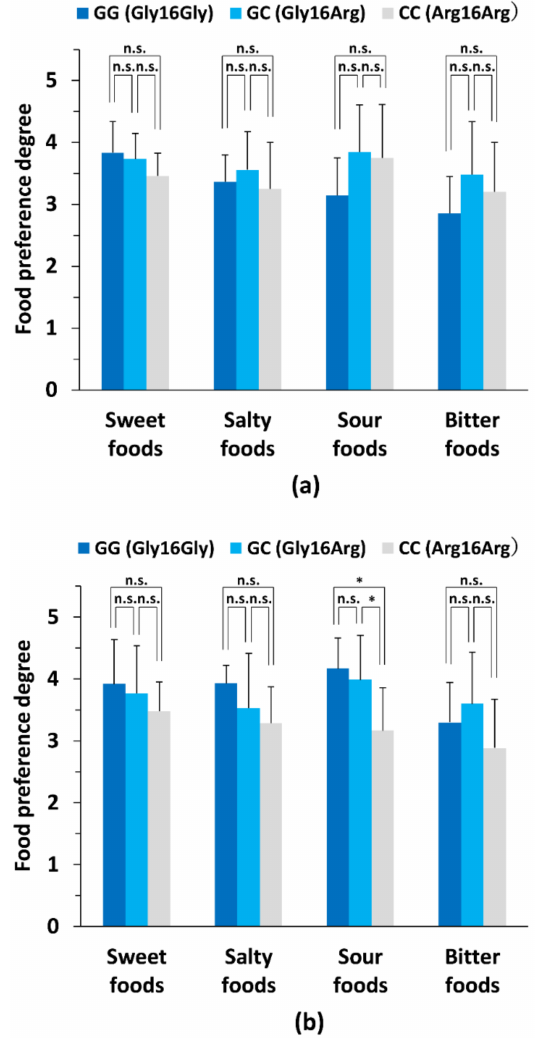
Figure 2. Comparison of primary taste preference degrees between genotype subgroups in male and female subjects. In the self-reporting questionnaire, to determine preferences for primary tastes, subjects rated their degree of taste preferences for a variety of tastants including salty, sour, sweet, and bitter on a scale of 1–5 as presented in Tables 4 and 5 as follows: scale 5, like very much; scale 4, like moderately; scale 3, neither like nor dislike; scale 2, dislike moderately; scale 1, dislike very much. The average preference degrees for each primary food taste were compared among the indicated genotype subgroups. ( a ) Comparison of primary taste preference degrees between the genotype subgroups in male subjects. For the comparison of average preferences of taste among the genotype subgroups (GG (Gly16Gly) genotype of ADRB2 ( ADRB2 GG subgroup), GC (Gly16Arg) genotype of ADRB2 ( ADRB2 GC subgroup), and CC (Gly16Arg) genotype of ADRB2 ( ADRB2 CC subgroup); n = 26), significant differences were found in average taste preference extents among the ADRB2 GG subgroup ( n = 7), the ADRB2 GC subgroup ( n = 15), and the ADRB2 CC subgroup ( n = 4) genotype subgroups in male subjects, identified by performing a one-way analysis of variance followed by the Holm–Sidak test for each indicated tastant. ( b ) Comparison of primary preference degrees between genotype subgroups in female subjects. For the comparison of average taste preferences among the genotype subgroups ( ADRB2 GG subgroup, ADRB2 GC subgroup, and ADRB2 CC subgroup; n = 26), significant differences were found in average taste preference degrees among the ADRB2 GG subgroup ( n = 6), the ADRB2 GC subgroup ( n = 13), and the ADRB2 CC subgroup ( n = 7) genotype subgroups in female subjects, identified by performing a one-way analysis of variance followed by the Holm–Sidak test for each indicated tastant. For ( a , b ), * p < 0.05; n.s., not